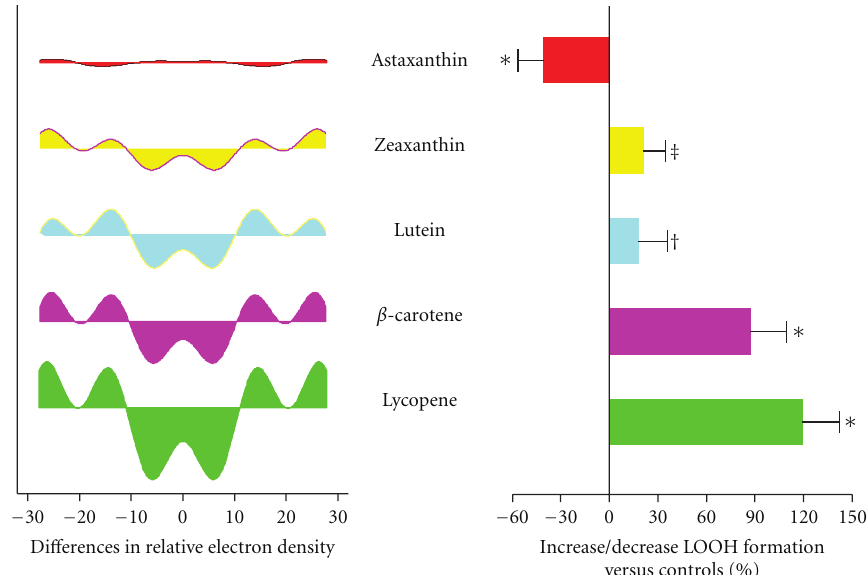
Figure 2: Antioxidant activity depends on molecular structure and localization (“Alignment”) in cellular/mitochondrial Membrane. Extent of deviation in the X-ray crystallographic pattern correlates with an increase in lipid peroxide formation. Correlation between membrane structure changes and LOOH formation (LOOH, lipid peroxide). Di ff erences in relative electron density as a function of treatment with various carotenoids in POPC membranes containing a C/P mole ratio of 0.2. For the peroxidation study, various carotenoids (10 μ M) were incorporated into DLPC membranes and underwent lipid peroxidation at 37 ◦ C for 48h. Expressed as percent increase or decrease in LOOH (lipid peroxide) formation compared to controls containing no carotenoids. ∗ P < 0 . 001 versus control; ‡ P < 0 . 01 versus control; † P < 0 . 05 versus control; n = 5 ∼ 6. (POPC, 1-palmitoyl 2-oleoyl-3-sn-glycerophosphatidylcholine), adapted from McNulty et al.